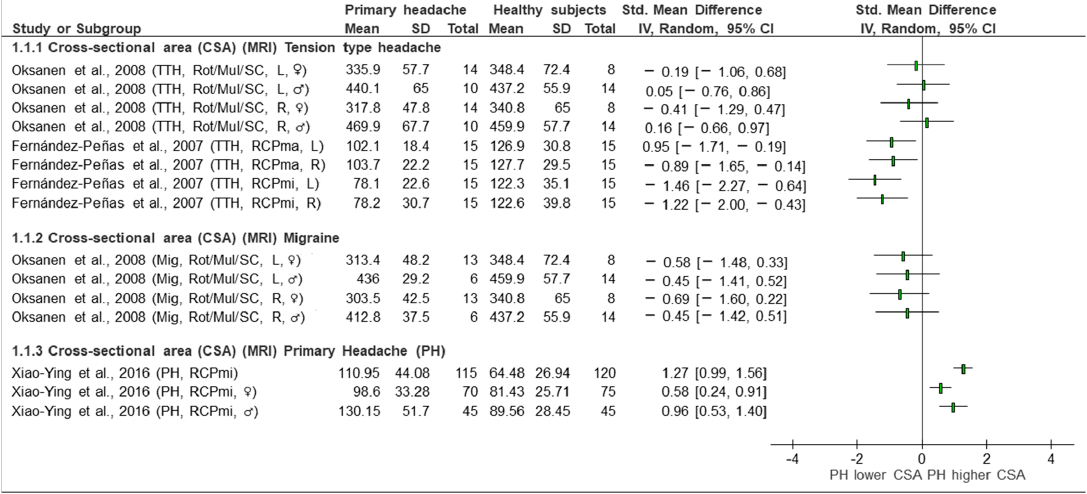
Figure 2. Forest plot of cross-sectional area based on magnetic resonance imaging (MRI). Graph explains the direction of change in muscle size in patients with primary headache towards a lower or